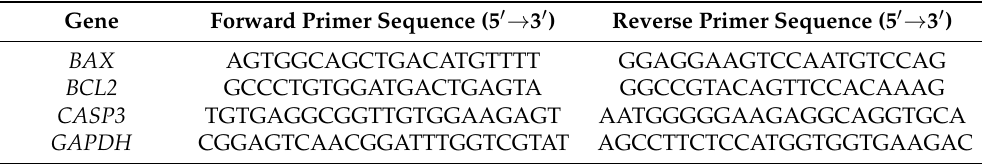
Table 1. Primers used for quantitative real-time